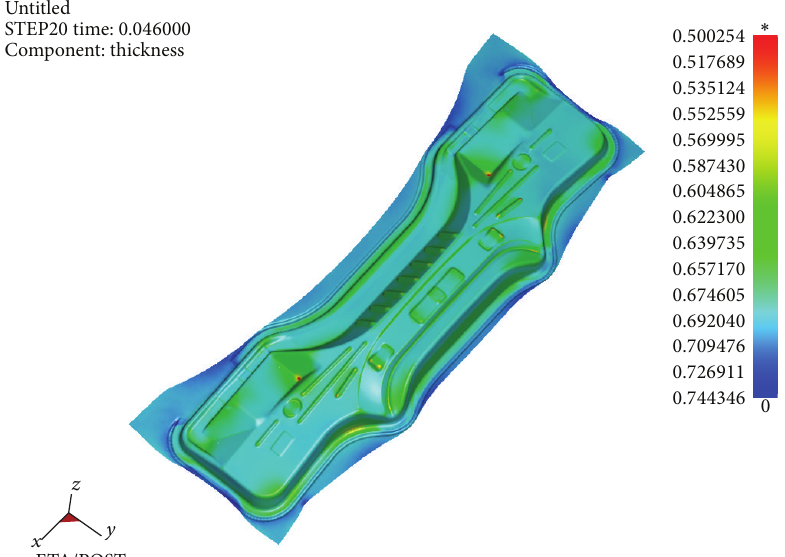
Figure 6: Thickness distribution of the forming parts for A1B3C3D1 optimized scheme.